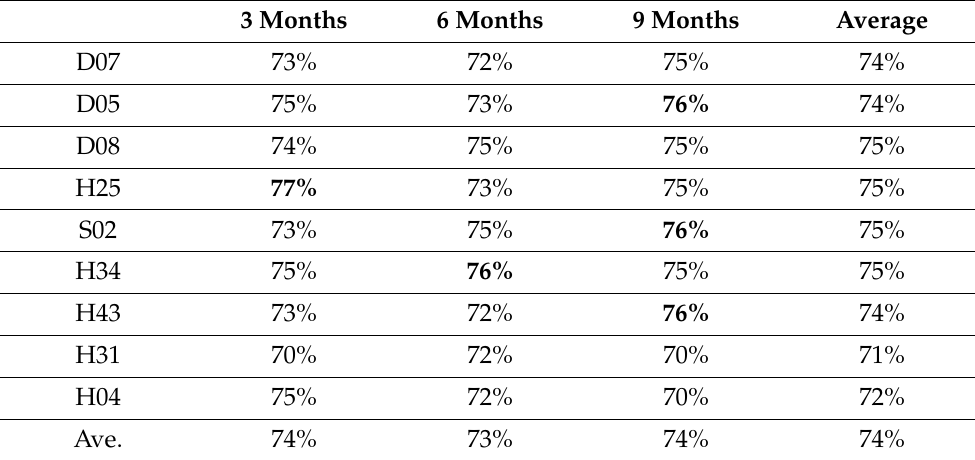
Table 3. Simulation experiment result: planned maintenance to each equipment (duration: 6 h).